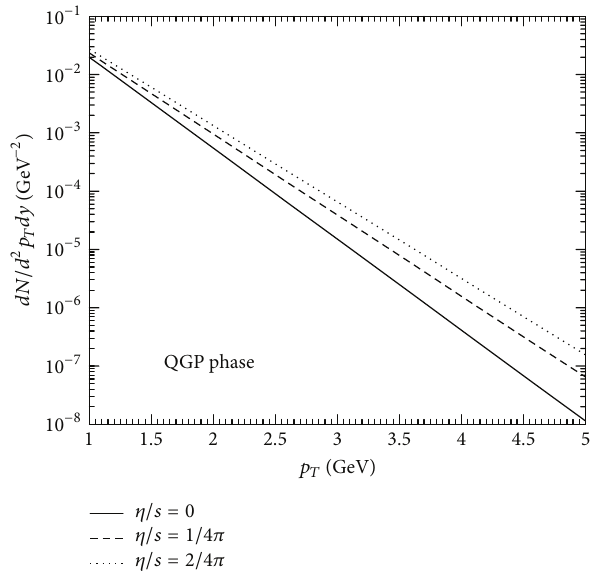
Figure 11: Transverse momentum distribution of thermal photons from QGP for various values of 𝜂/𝑠 in the scenario